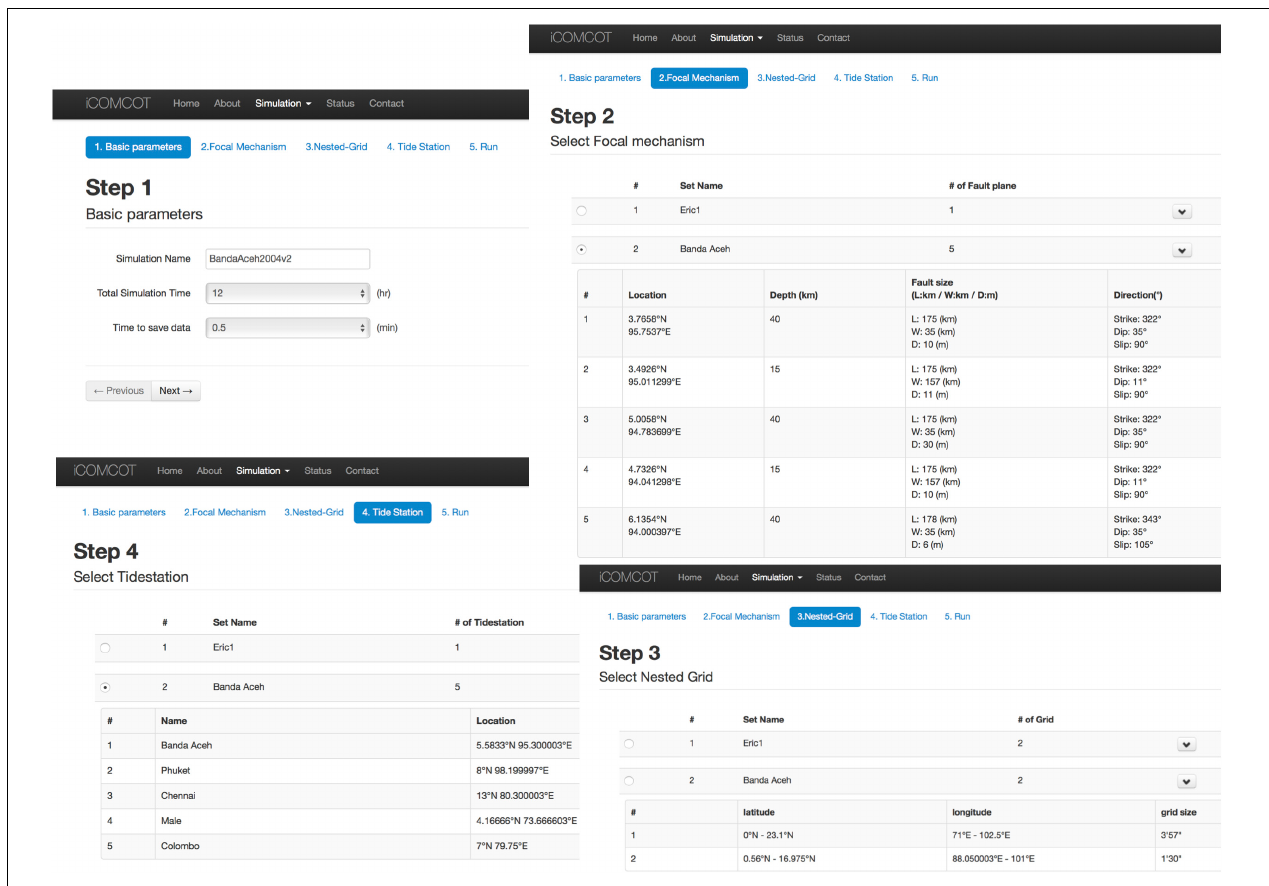
FIGURE 2 | iCOMCOT simulation workflow exemplified by an experiment case of the 2004 Indian Ocean earthquake and tsunami. Before running the simulation, four configurations have to be defined in advance. Step 1 is to initialize the task by naming and defining the duration of the simulation time (in hours) and time interval (elapsed time between two saved simulation data). Step 2 is to set up focal mechanism parameters of the earthquake, including the epicenter location (latitude and longitude), depth, fault Size (length, width and depth in kilometer), and direction (strike, dip and rake in angles). Step 3 is to determine the nested grid domains of the simulation. Step 4 is to designate the observation sites (tidal